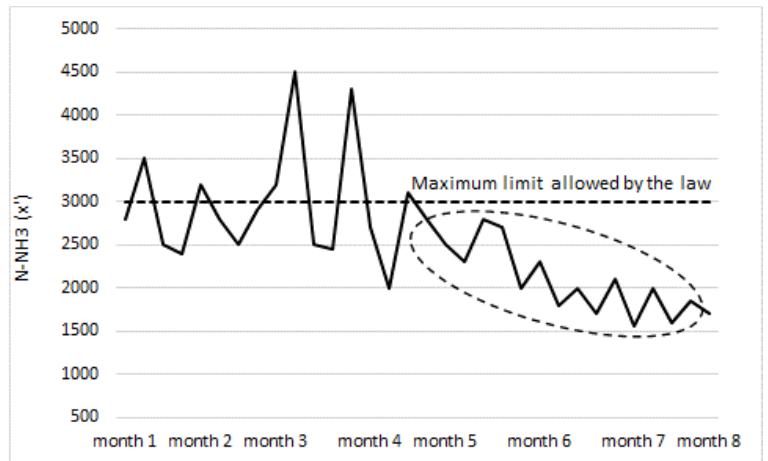
Figure 5. Concentration of ammoniacal nitrogen.